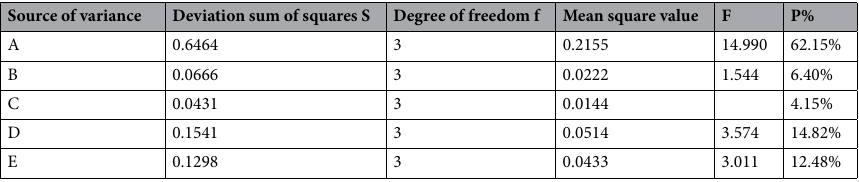
Table 12. Analysis of